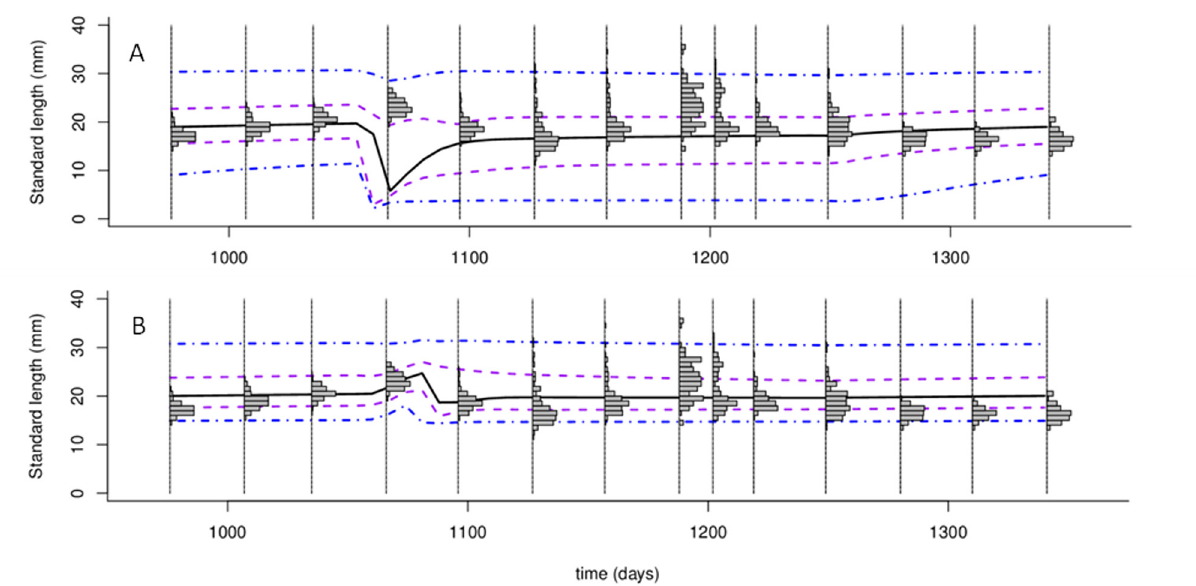
Fig 7. Zebrafish length distributions predicted compared to the length observed by Spence et al. [24]. (A) Predicted length distributions of all fish. (B) Predicted length distributions of fish > 15 mm. Black full lines represent the median length, purple dotted lines represent the first and third quartile of the fish length, and blue lines represent the limits of 95% of the fish length. Bar plot represent the distribution of the length of the fish sampled by Spence et al. [24] (sample of 120 fish).